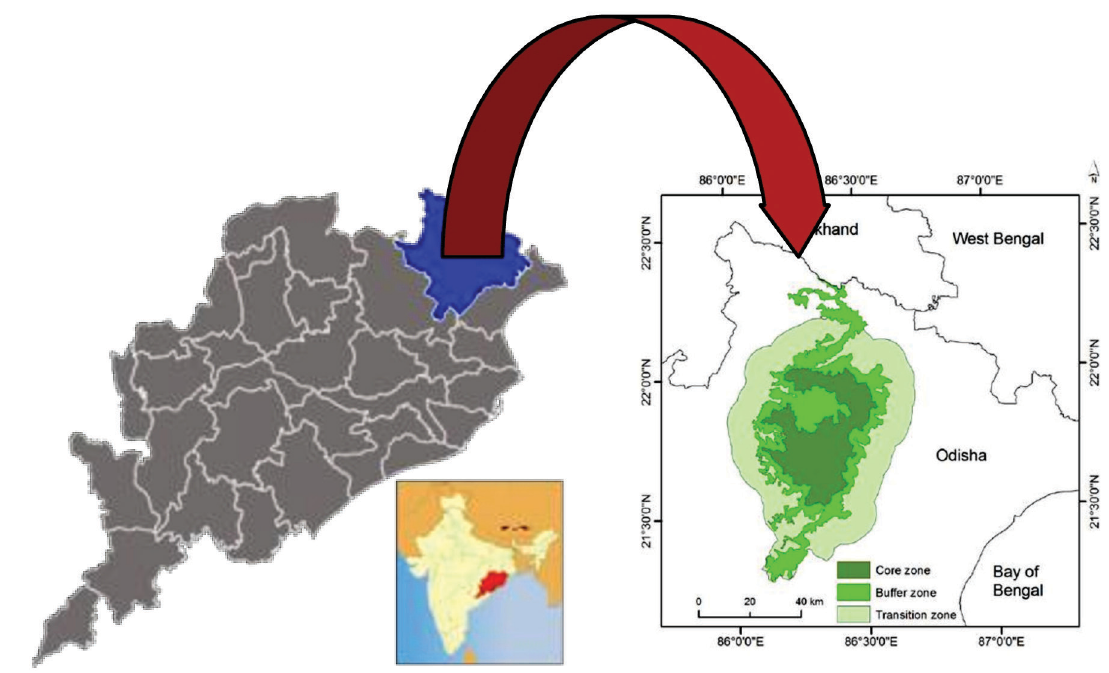
FIGURE 1 - Collection site of Experimental plant